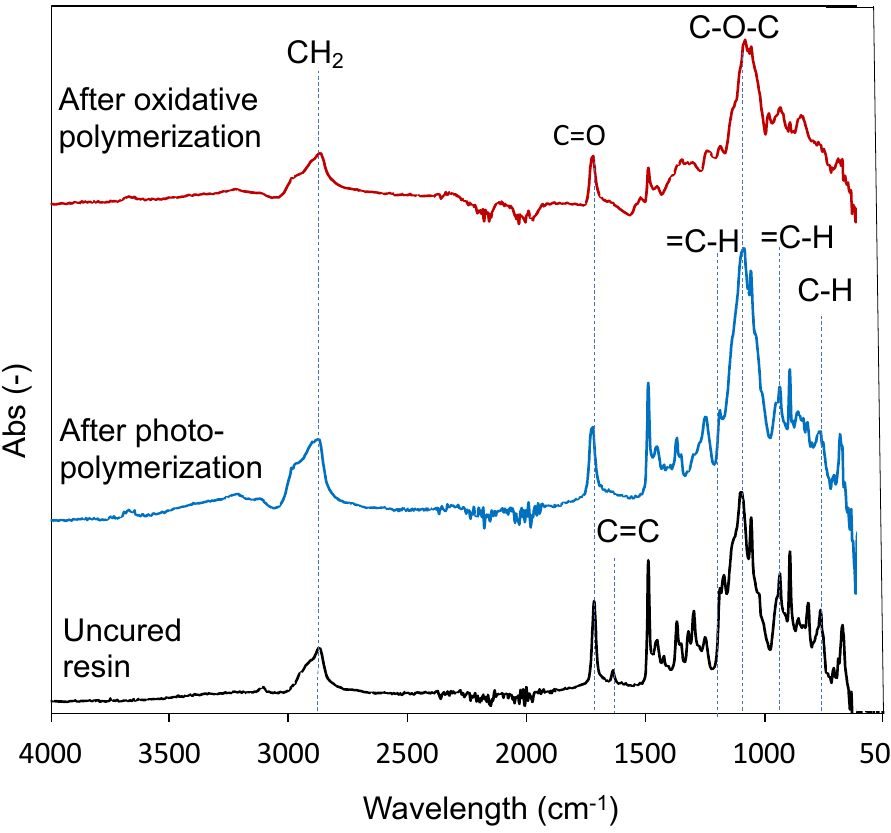
Figure 4. ATR-FTIR spectra of the uncured resin containing EDOT, after the photopolymerization of the resin, and after oxidative polymerization of the resin.